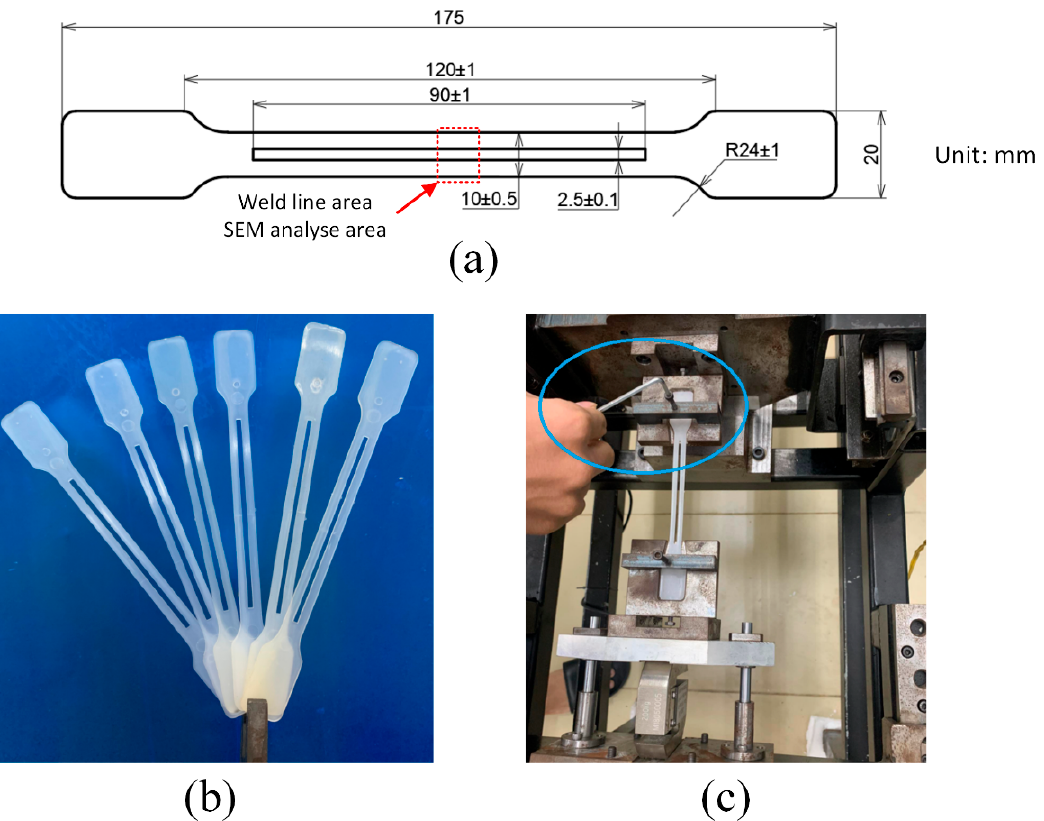
Figure 2. Testing samples under the standard of ASTM D638 ( a ), molded parts for testing ( b ), and fatigue testing machine ( c ).